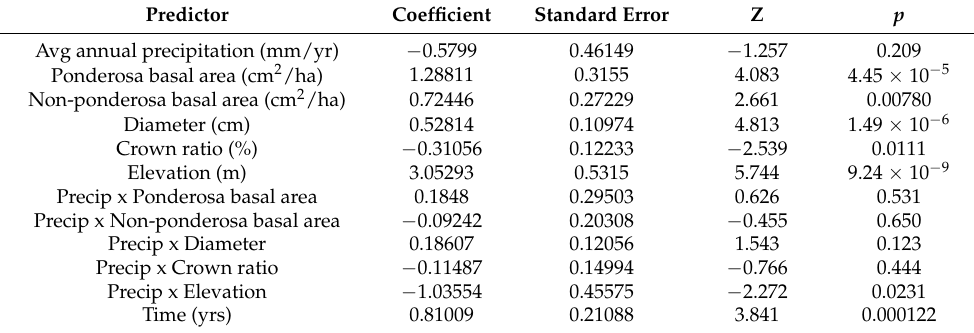
Table A5. Outputs from the Objective 3 model analyzing all possible interactions between precipi- tation and stand- and tree-level variables. Predictors have been mean-centered and scaled by their standard deviation.